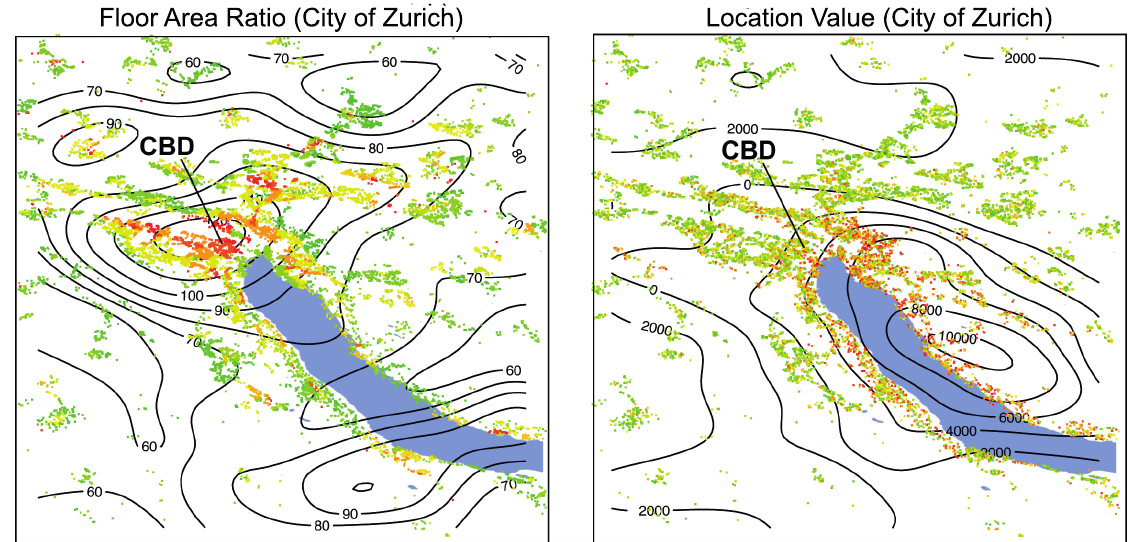
Figure 5. Nonparametric estimates of location value and land quality. (This figure shows the land quality measured in terms of the floor area ratio ( FAR ) in the left-hand side graph, while the right-hand side graph depicts the nonparametric surface of the location value. The location value reflects the central location’s attractiveness with its highest value in the CBD. As central areas have higher FAR , land prices increase in the CBD and decrease with distance to the